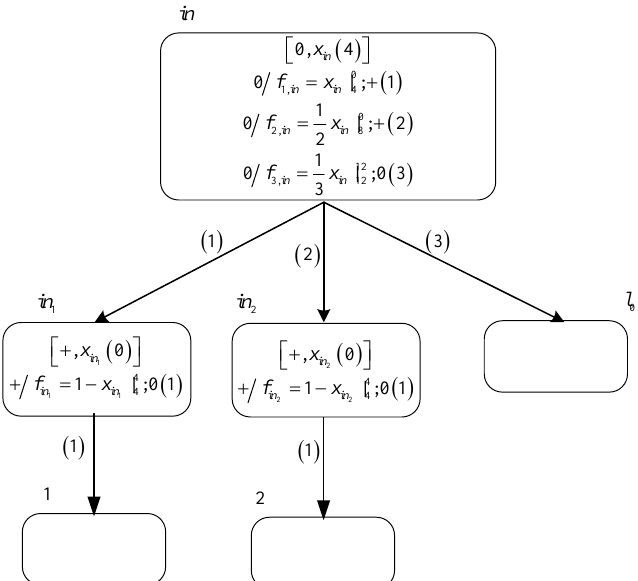
Π . Figure 10. The INPUT module in system Π 3 . 3